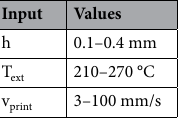
Table 2. Varied parameters and their